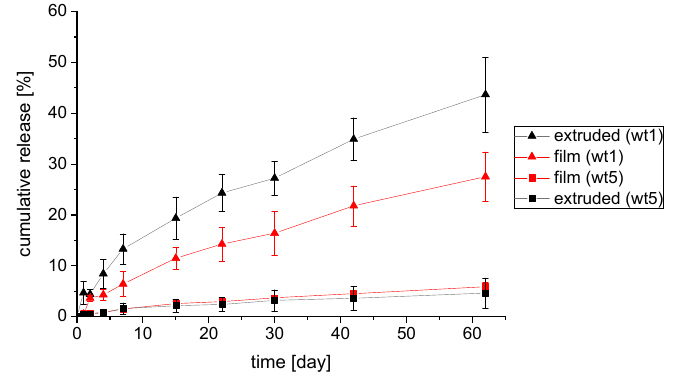
Figure 6. Drug release study of TA from the SIBS matrix.